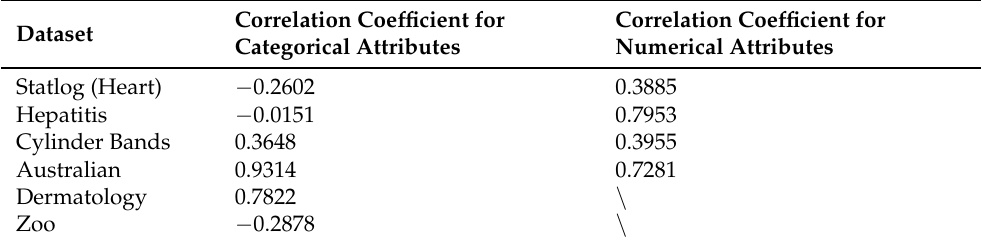
Table 3. The correlation coefficient between dependencies and weights in each mixed dataset.